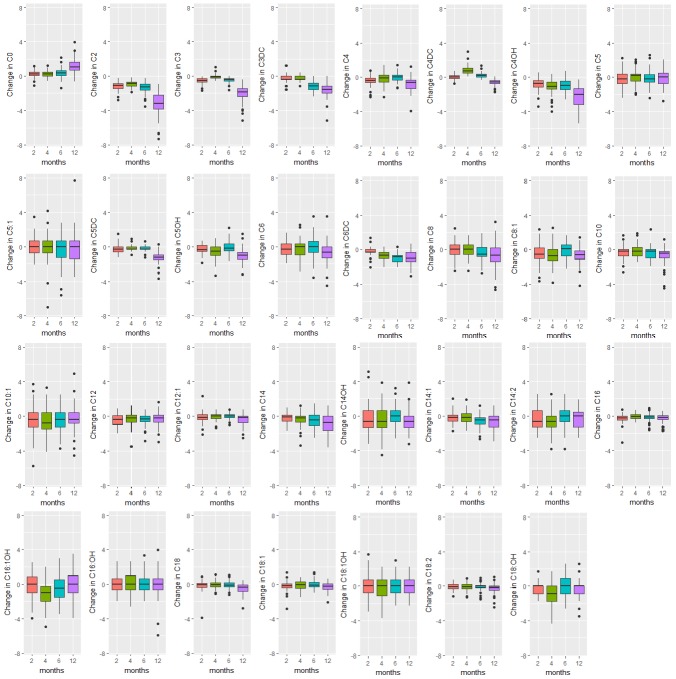
Acylcarnitines.Boxplots of the change in analyte levels after 2-, 4-, 6-, and 12-months of storage from baseline. The lower whisker = smallest observation greater than or equal to lower hinge - 1.5 * IQR, and the upper whisker = largest observation less than or equal to upper hinge + 1.5 * IQR.